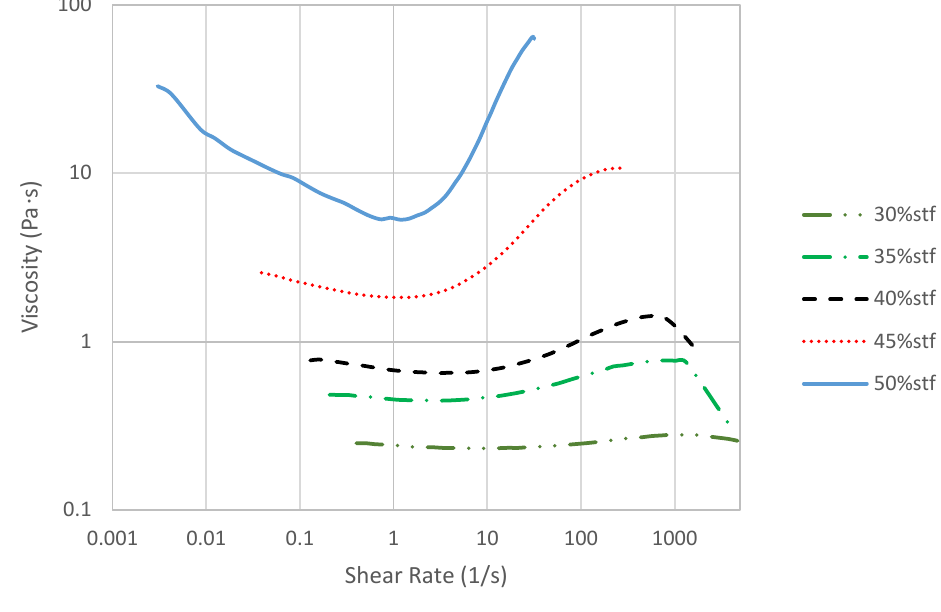
Figure 3. Shear rate effect on viscosity at 25 °C.